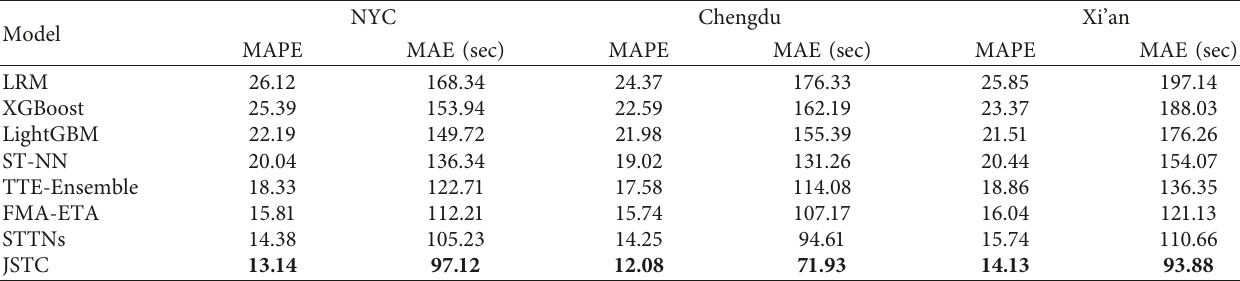
Table 3: Comparison of all models’ results on the NYC, Chengdu, and Xi’an datasets. NYC Chengdu Model